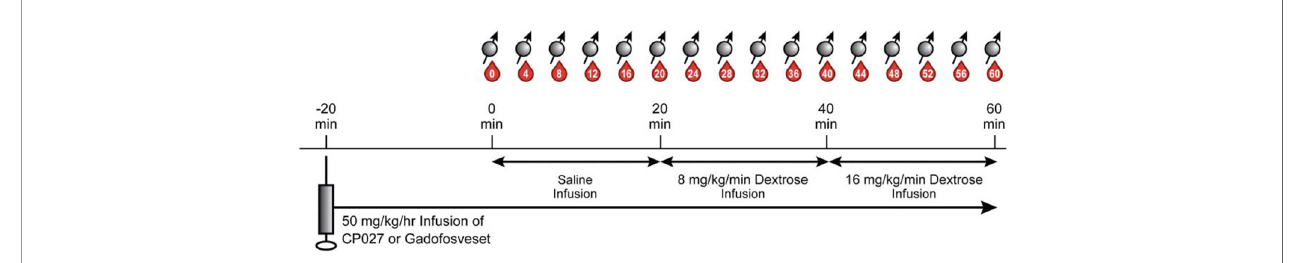
FIGURE 1 | Altered GGI paradigm. After animals were anesthetized and anatomical images were acquired, 50 mg/kg/hr of contrast agent was infused intravenously. After waiting 20 min for the agent to circulate, a separate saline infusion was administered for 20 min (0 min – 20 min), followed by 20 min of 8 mg/kg/min dextrose (20 min – 40 min), and then 20 min of 16 mg/kg/min of dextrose (40 min – 60 min). Blood sampling (denoted as red drops) and breath-held T1W images (spin symbols) were acquired every